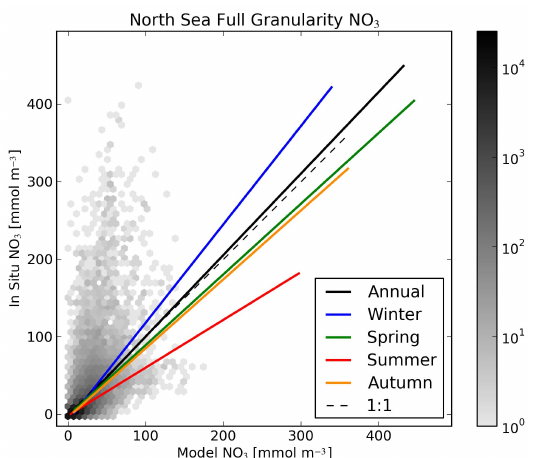
Fig. 8. Two-dimensional binned scatter plot of full granularity matched model data against in situ measurements for the North Sea phosphates. The solid coloured lines show the linear regression fits for the full annual and seasonal data, and the dashed line is the line of unity slope that passes through the origin. The shading of the binned data density plot is scaled such that darker hue indicates logarithmically higher data density.